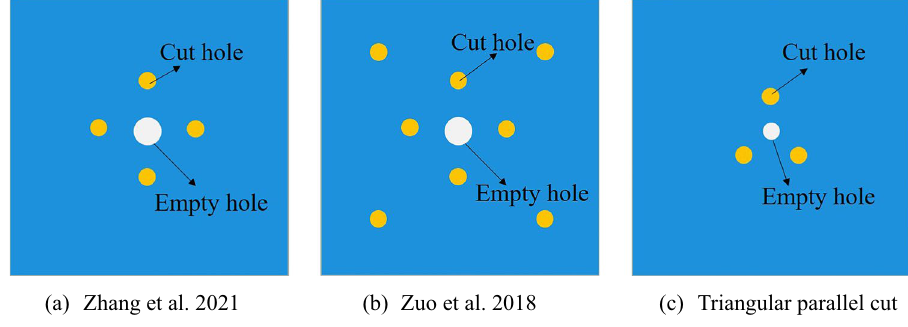
Fig. 15 Several different deep hole cut blasting schemes. a Zhang et al. 2021; b Zuo et al. 2018; c Triangular parallel